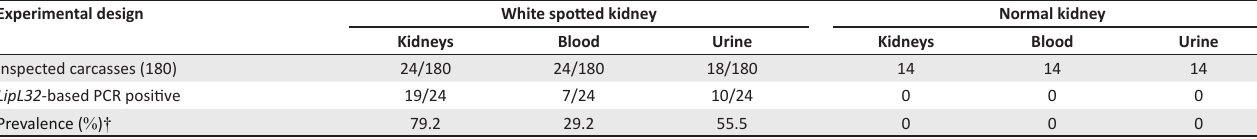
PCR, polymerase chain reaction. † , Suspected kidneys = 13.3 %